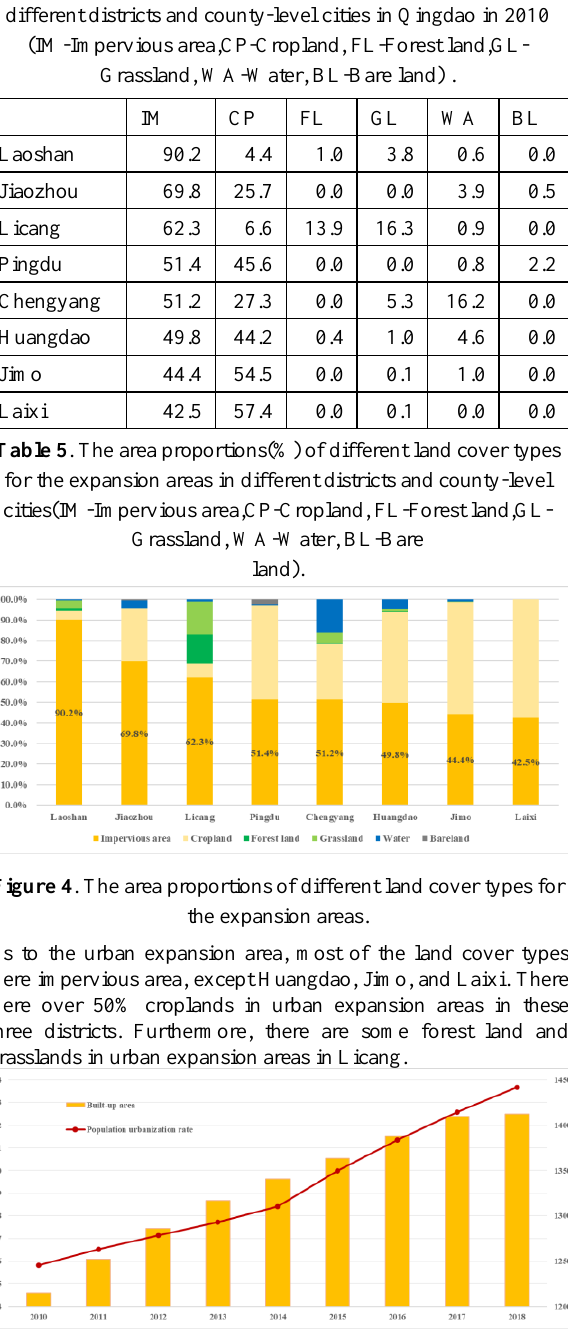
Figure 5 . Variations of urban land areas and people urbanization rate from 2010 to